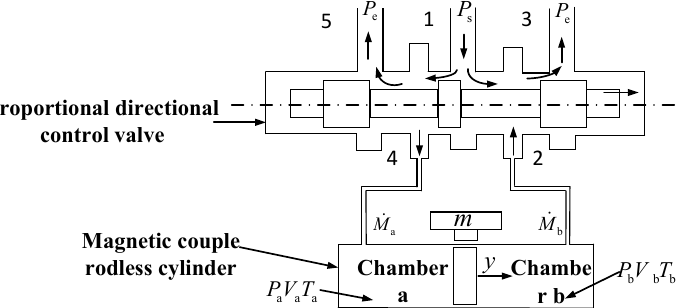
Figure 3. Gas flow schematic for valve control cylinder systems.